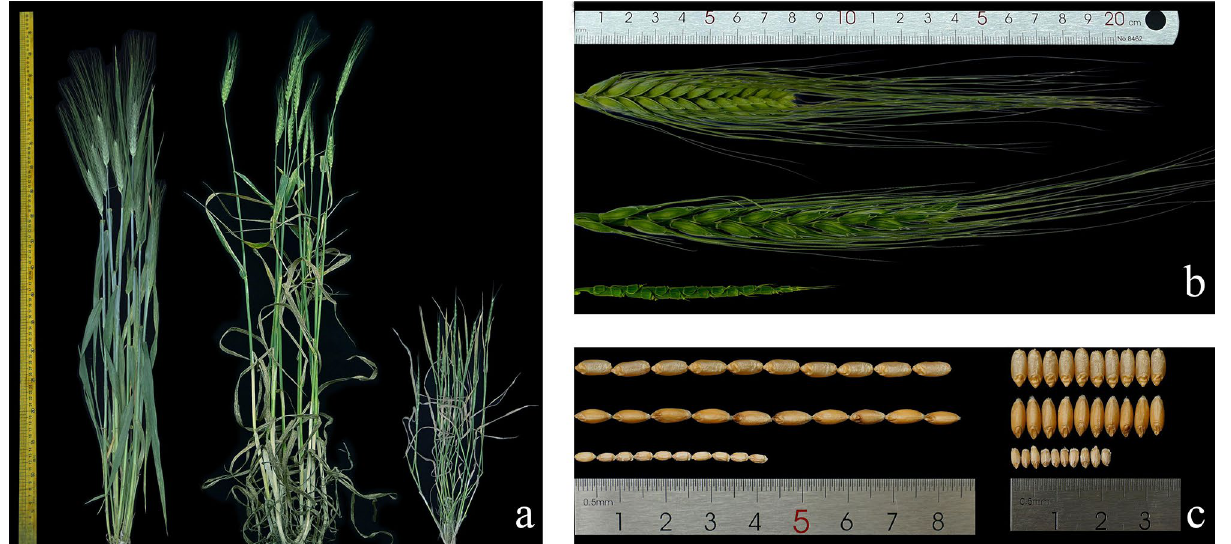
Figure 2. Morphology of synthetic hexaploid wheat and its parents. ( a ): Ma (left), Syn-SAU-119 (middle) and AS96 (right); ( b ), ( c ): Ma (top), Syn-SAU-119 (middle) and AS96 (bottom).